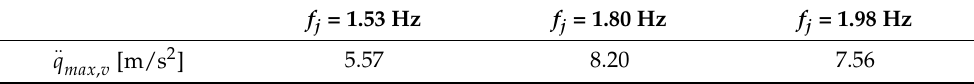
Table 10. Peak accelerations due to sparse traffic according to S É TRA